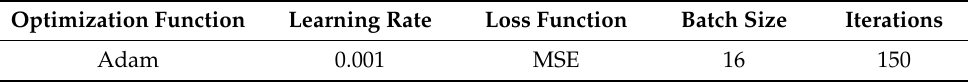
Table 1. Hyper-parameters of models.